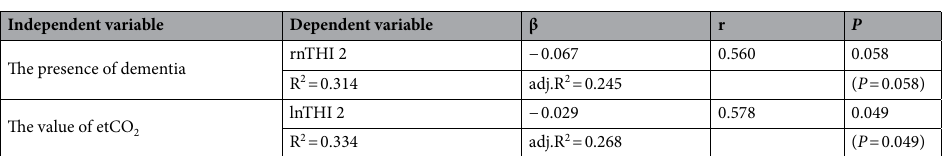
Table 2. The independent associations between the nTHI and other variables. Definition of independent variable: presence of dementia (1), and no presence of dementia (0). rnTHI2 right normalized tissue hemoglobin index, lnTHI left normalized tissue hemoglobin index.